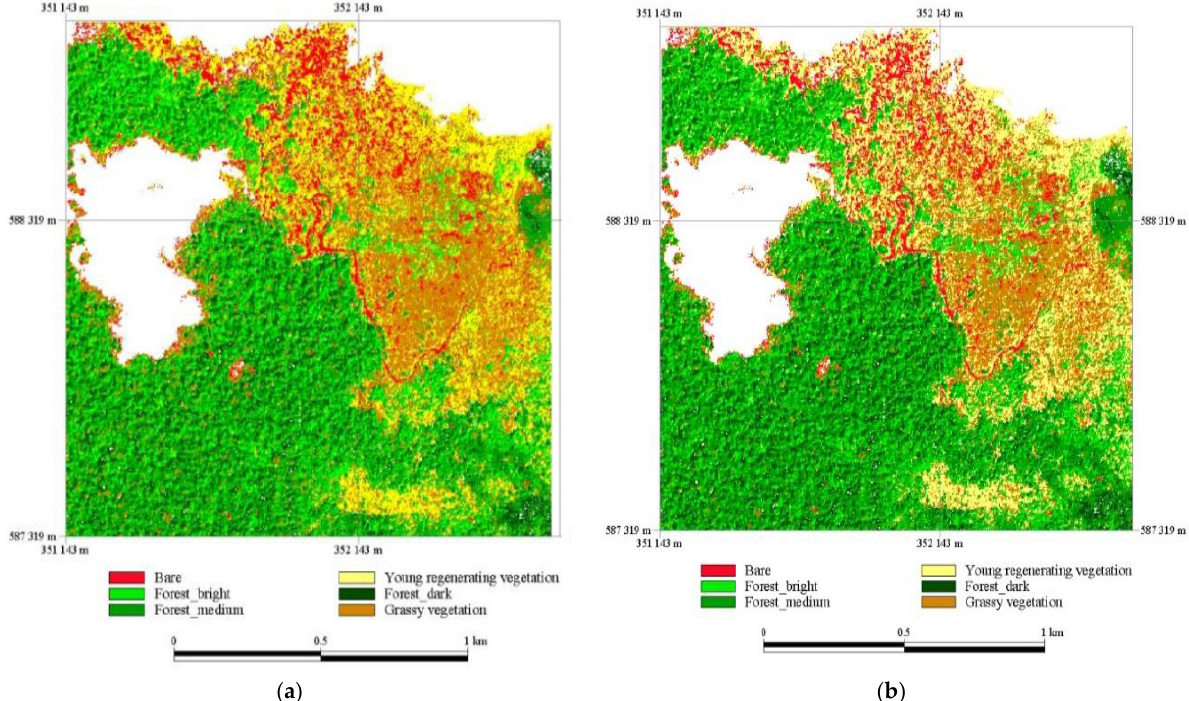
Figure 2. Supervised classification using ( a ) pixel-based approach and ( b ) object-based approach .